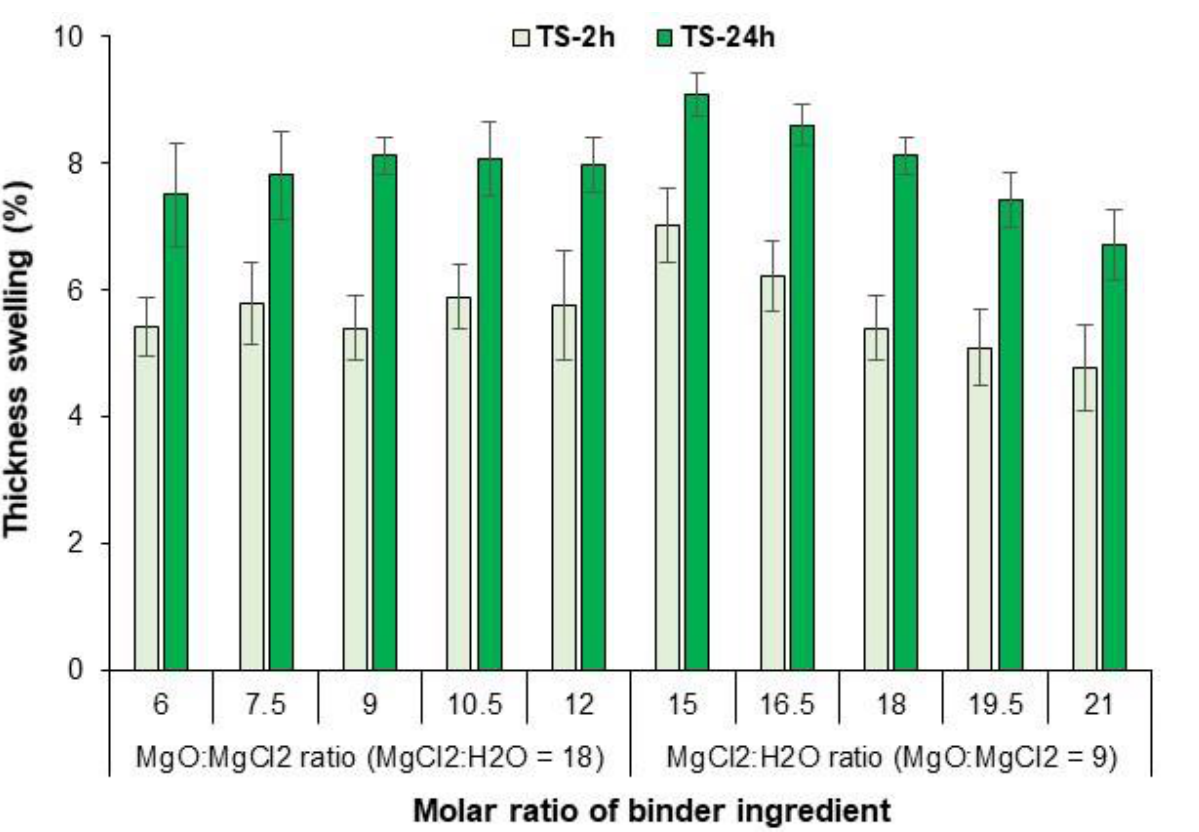
Figure 9. Thickness swelling of plywood samples during bending using MOC binders with different molar ratios of the components.